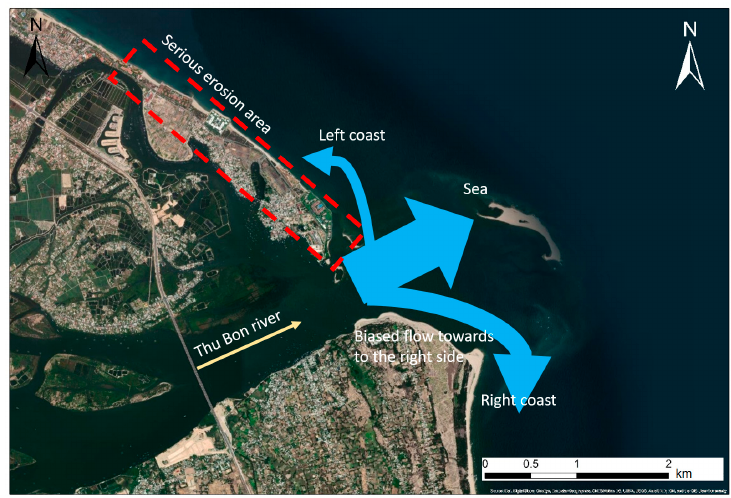
Figure 14. Imbalance of longshore sediment supply at Cua Dai estuary [39].